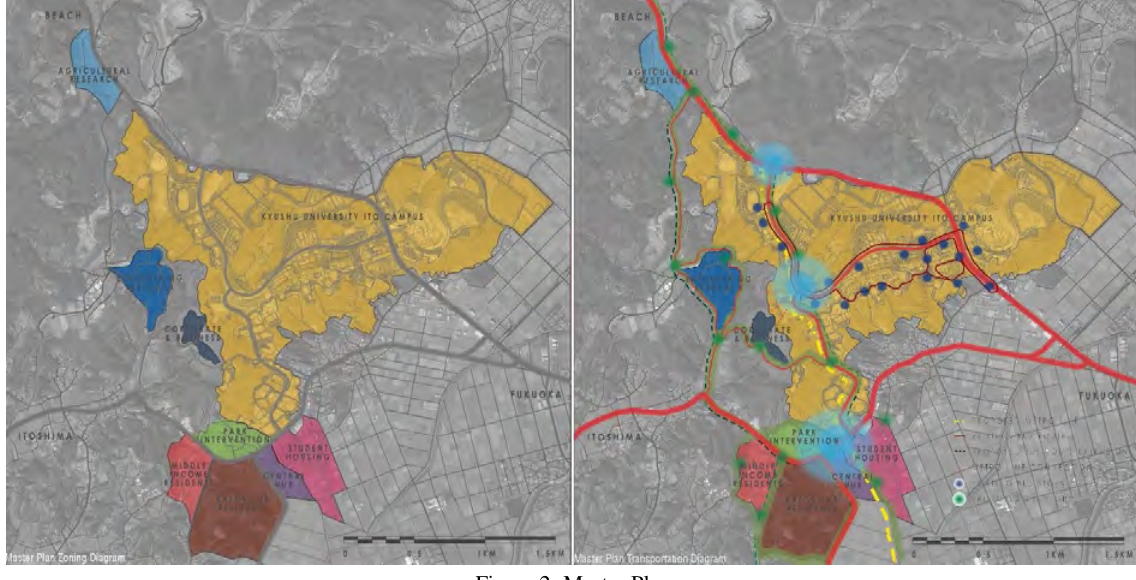
Figure 2. Master